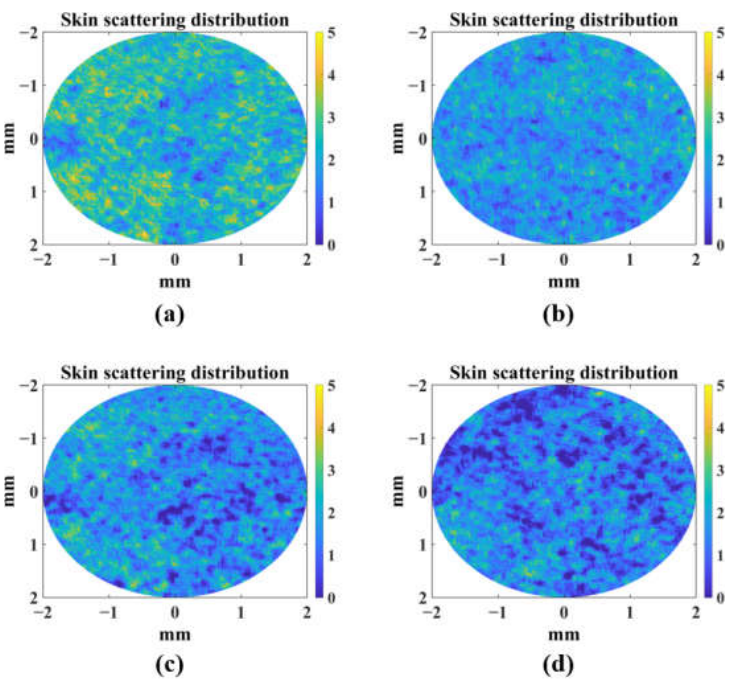
Figure 10. Scattering coefficient distribution of AS samples in UV group: ( a ) day 1; ( b ) day 2; ( c ) day 3; ( d ) day 4.